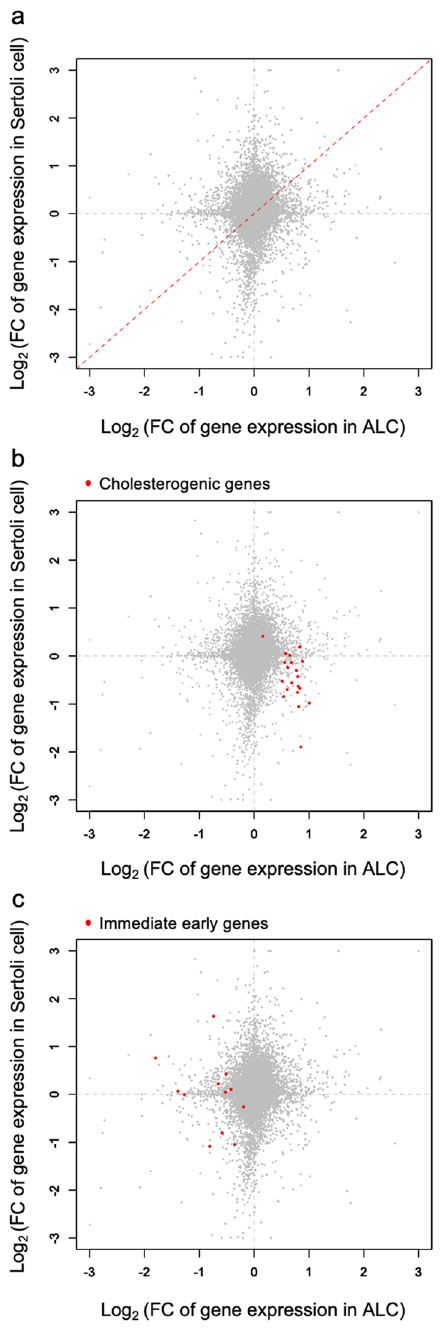
Figure 4. Differentially affected gene expression in XX/ Sry ALCs and Sertoli cells. ( a – c ) Fold changes in gene expression were calculated as the ratio of the CPM values for XX/ Sry Sertoli cells to those for XY Sertoli cells, and of CPM values for XX/ Sry ALCs to those for XY ALCs. ( a ) Whole genes were plotted according to the calculated values. The dotted red line indicates where genes that are similarly expressed in the two cell types would fall. The horizontal and vertical axes represent log 2 fold change (FC) in gene expression in the ALCs and Sertoli cells, respectively. A dot corresponds to a single gene. ( b ) Cholesterogenic genes are depicted as red dots. ( c ) Immediate early genes are depicted as red dots. R software version 3.4.3 (https ://www.r-proje ct.org) was used to draw the plots in ( a – c